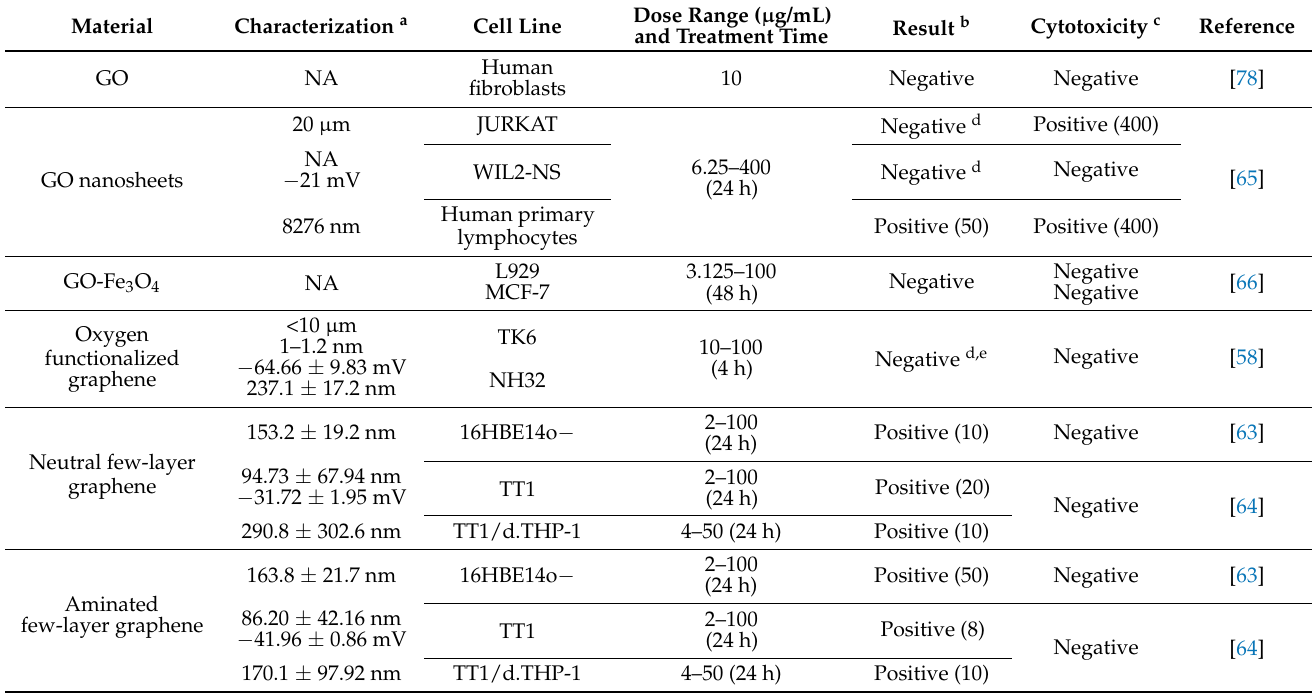
Table 1. In vitro studies assessing the genotoxicity of GBMs using the micronucleus assay. Material Characterization